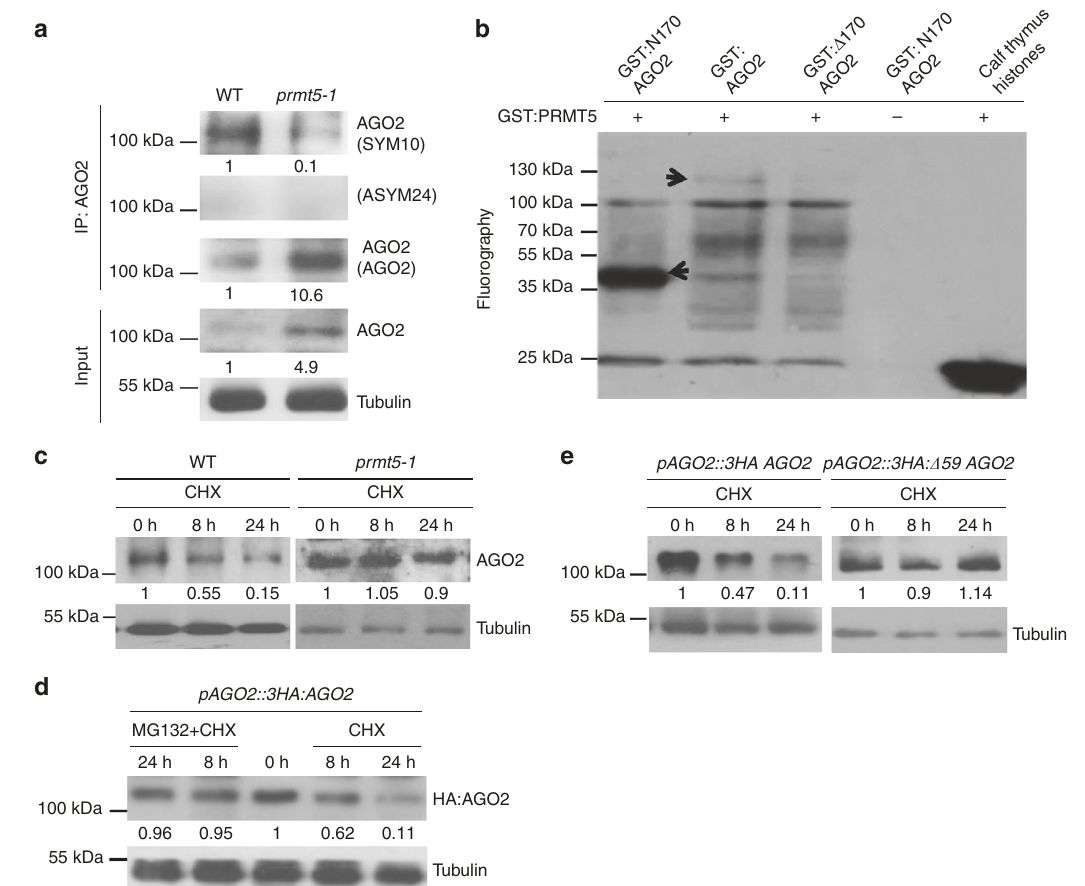
Fig. 2 PRMT5 catalyzes AGO2 methylation at the AGO2 N-terminal GAR region and regulates AGO2 degradation. a In vivo methylation of AGO2 requires PRMT5. AGO2 was immunoprecipitated with the anti-AGO2 antibody and symmetrically dimethylated arginines (sDMA) were detected using the anti- symmetric-dimethyl-arginine antibody (SYM10). The anti-asymmetric-dimethyl-arginine antibody (ASYM24) was used to detect aDMA. b The N -terminal region of AGO2 is required for PRMT5-mediated methylation of AGO2 in vitro. Recombinant, GST-tagged AGO2 proteins were incubated with GST: PRMT5 in the presence of the methyl donor [ 3 H] S -adenosyl-L-methionine. The 170 residue N -terminal region of AGO2 (GST:N170 AGO2) and full-length AGO2 protein (GST:AGO2) are both methylated in the presence of GST:PRMT5 (arrows), but AGO2 proteins with N-terminal truncations (GST: Δ 170 AGO2) are not. c AGO2 degradation depends on the presence of PRMT5. Protein synthesis was inhibited through 50 µ M cycloheximide (CHX) treatment to show that AGO2 levels decrease over time in WT plants, while AGO2 levels are maintained in the prmt5 – 1 mutant. d AGO2 degradation is 26S proteasome-dependent. Treatment with the 26S proteasome inhibitor MG132 (40 µ M) prevents AGO2 degradation in the ago2-1 complementary plants ( pAGO2:3HA:AGO2 ). e Levels of AGO2 were compared in ago2-1 expressing full-length AGO2 ( pAGO2:3HA:AGO2) or truncated AGO2 ( pAGO2:3HA: Δ 59 AGO2) in the presence of 50 µ M CHX over 0, 8, and 24 h. The protein levels of full-length AGO2 and truncated AGO2 ( Δ 59 ) were tested using anti-HA antibodies. Tubulin levels were used to show equal loading for all western blots. In all panels, signal intensity was calculated using